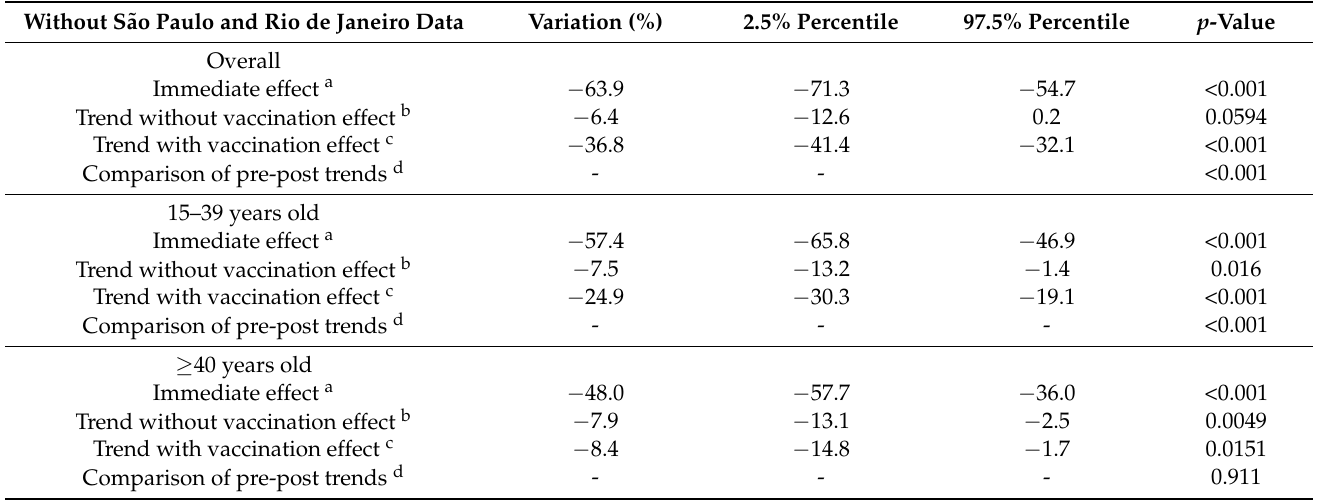
Table 3. Time-series model estimates of the impact of hepatitis A vaccination on yearly cases number for age groups 15–39 years old and ≥ 40 years old subtracting data from S ã o Paulo and Rio de